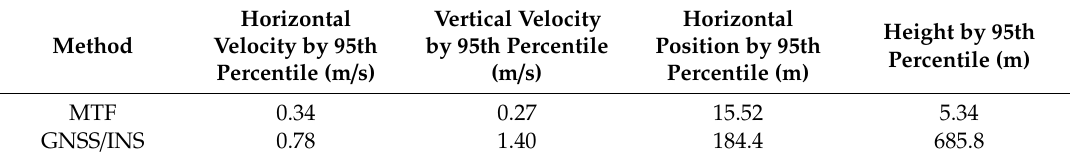
Figure 19. The position and velocity errors of the traditional GNSS/INS tightly coupled integration in the satellite outage case. Table 6. Statistical analysis of the errors of the MTF method and the traditional GNSS/INS tightly coupled integration in the satellite outage context in the experimental test.